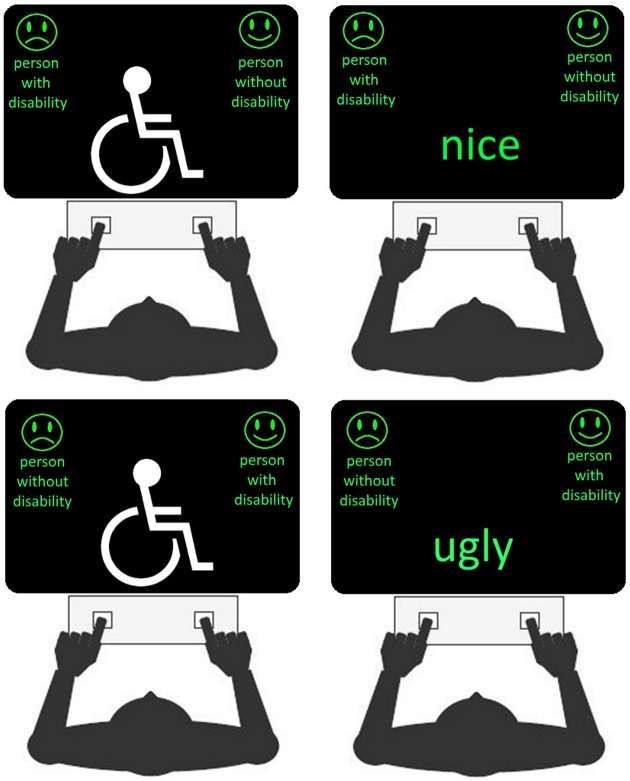
The figure depicts four examples of screens used during the critical IAT blocks.The two left panels depict examples of words stimuli; in the two panels on the right the pictures of children with disability are substituted with an icon for illustrative purpose: during the tests, instead of the icon, real images of children with or without disabilities were presented to the participants. The panels on the top row report the case of Block 3 and Block 4 where the stimulus-response association was learned by mapping the left key, pictures of children without disability and negative-valued words. The panels on the bottom row report report the case of Block 6 and Block 7 where the stimulus-response association emerged by mapping the left-key with pictures of children with disability and positive-valued words. The figures are original and not copyrighted.